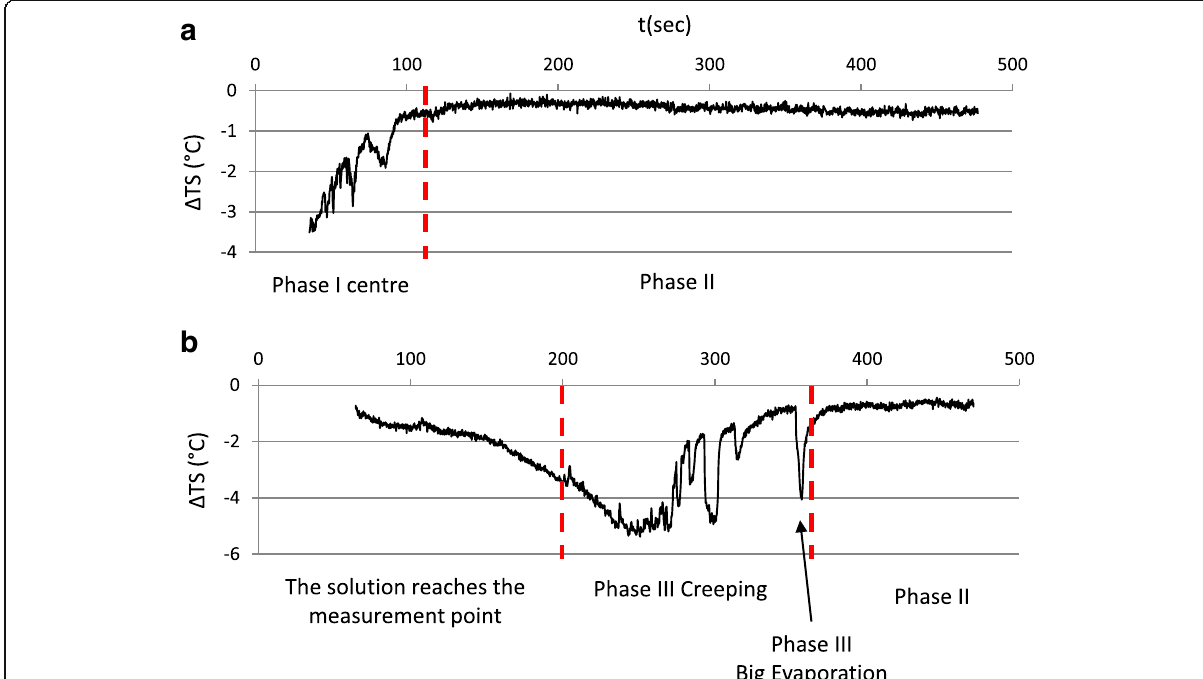
Fig. 4 Representative profiles of a droplet evaporation measured with IRT. a IRT profile measured in the droplet center (zone A). b IRT profile measured out of the droplet edge (zone